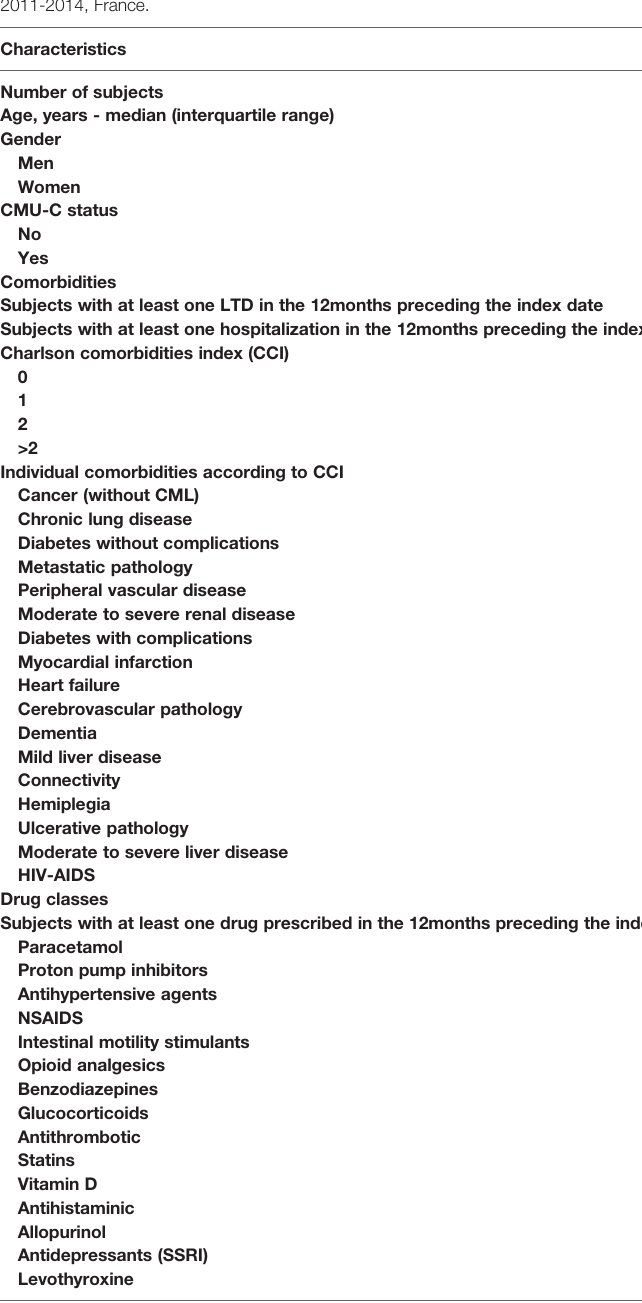
TABLE 1 | Description of population characteristics and comorbidities (in the 12 months preceding the index date) in incident “ CML ” subjects identi fi ed in the SNDS, 2011-2014,